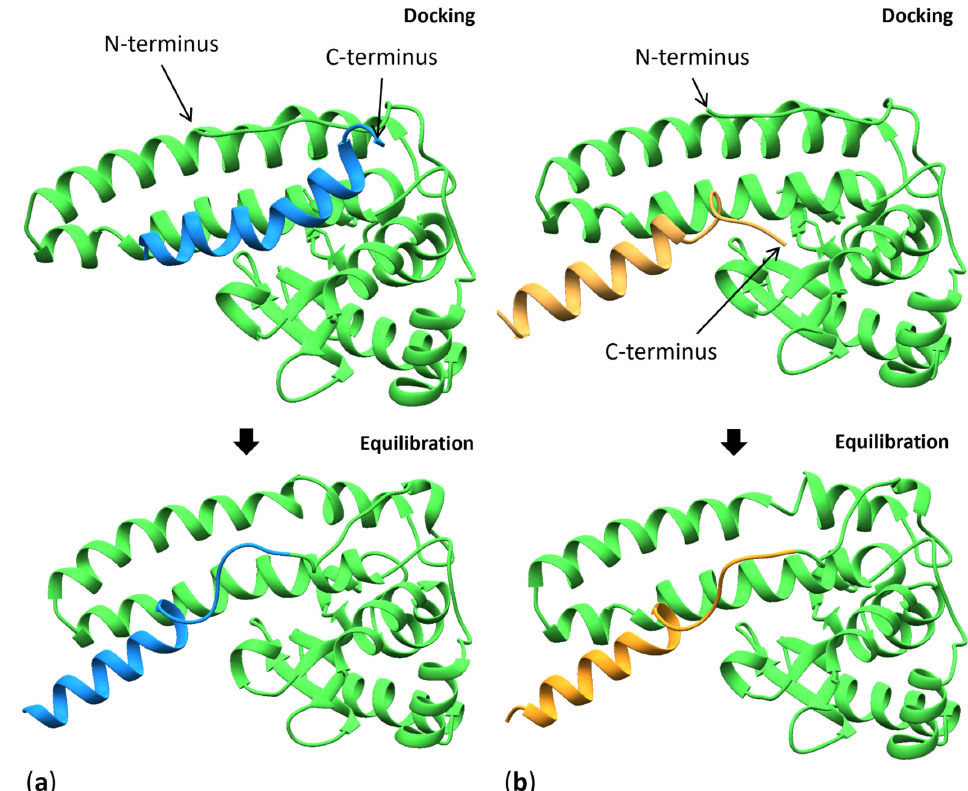
Figure 3. A cartoon representation of the docking and post-minimization results used in MD for ( a ) the alanine and ( b ) the valine variants. The C terminus of the MTS (blue and orange) and the pro- tein’s N terminus (green) are